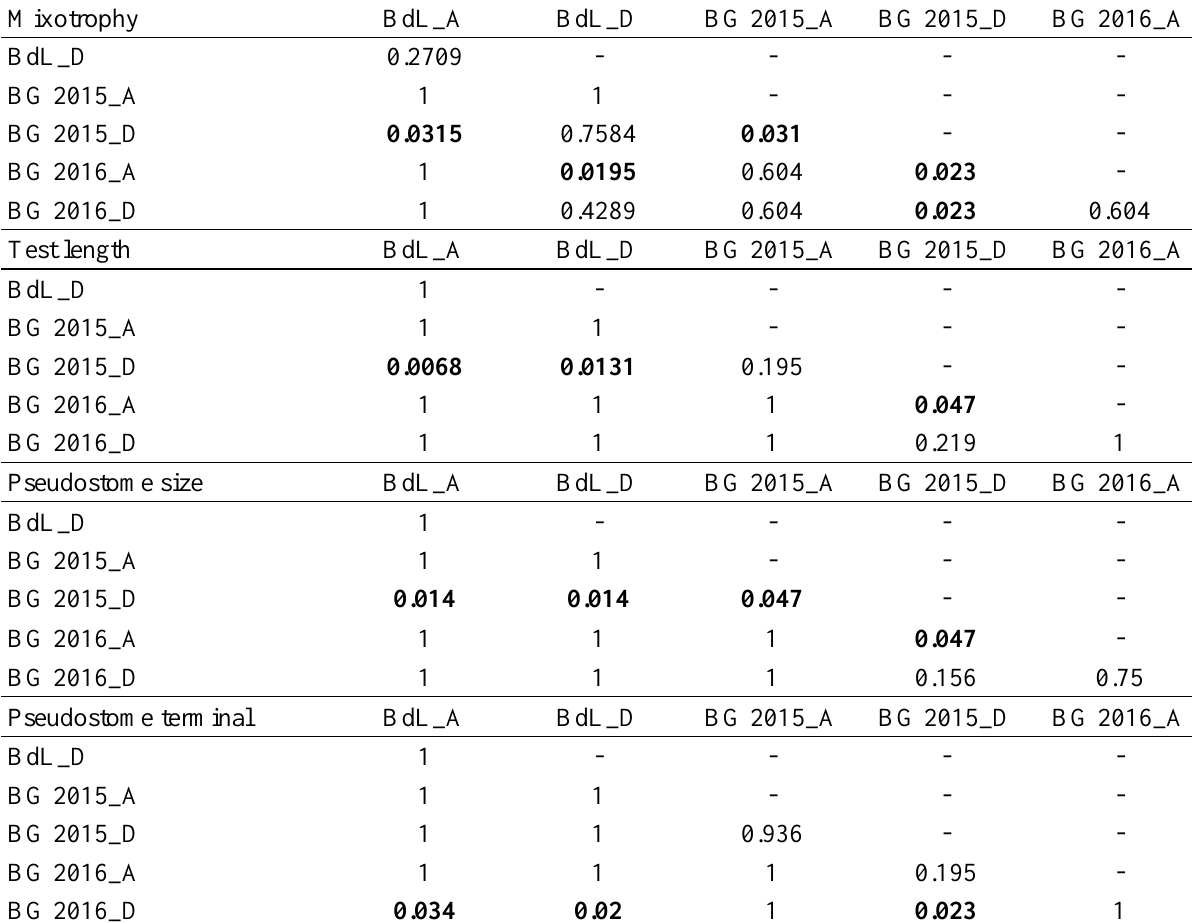
Table A3. Pairwise comparison (Wilcoxon rank test with “Holm” correction for the p-value) of the community weighted mean (CWM) of selected traits between pairs of datasets (Bois-des-Lattes: BdL; Neuchâtel Botanic Garden: BG (2015 and 2016); living assemblages: A; dead assemblages: D). Significant p-values (< 0.05) are shown in bold